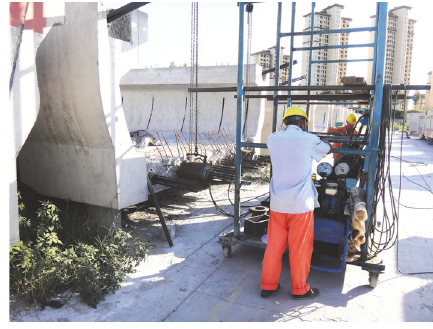
Figure 7: Posttensioning construction of U-shaped girder.